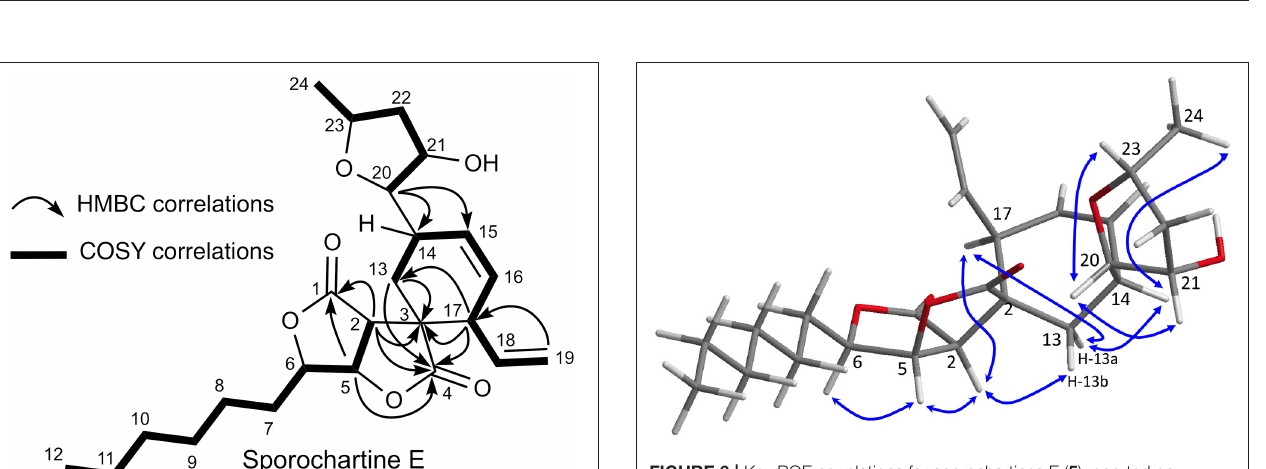
sporochartines B ( 2 ), D ( 4 ), and E ( 5 ). This finding merits future of cytotoxic